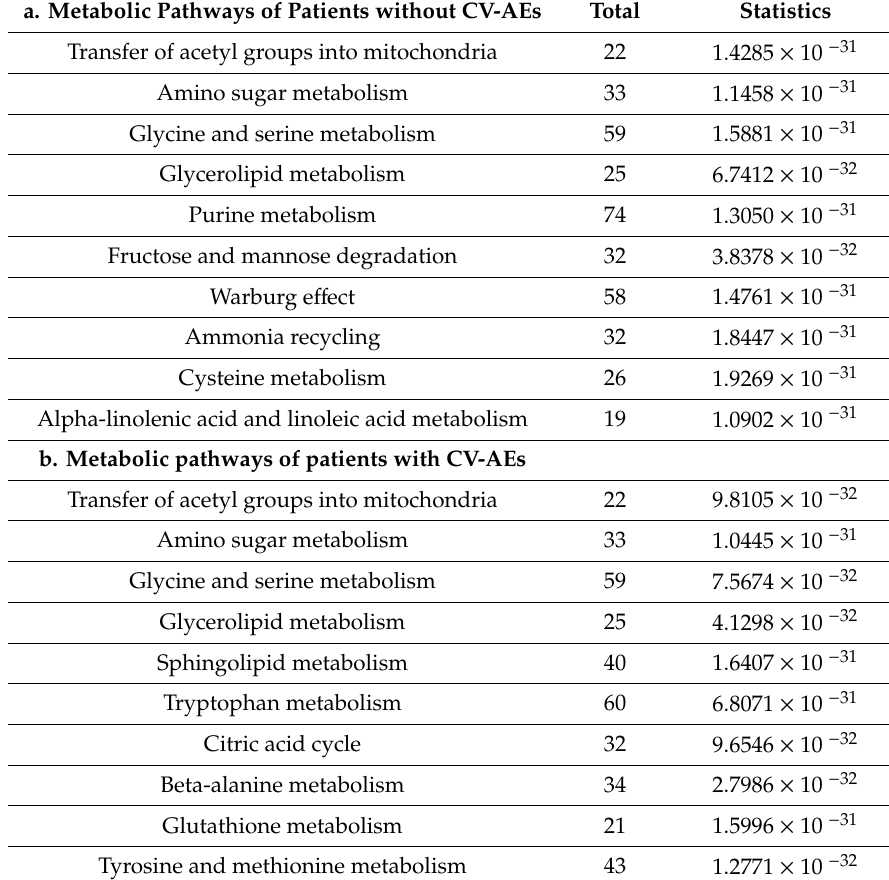
Table 2. Graphic synopsis of metabolic pathways of patients (a) without CV-AEs, and (b) with CV-AEs. a. Metabolic Pathways of Patients without